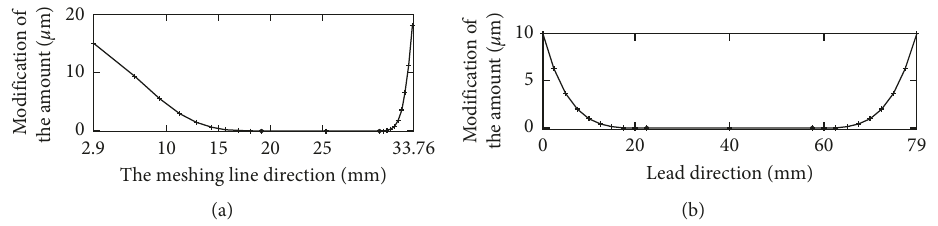
Figure 1: Theoretical modification curve: (a) profile modification curve along meshing line direction; (b) lead modification curve.